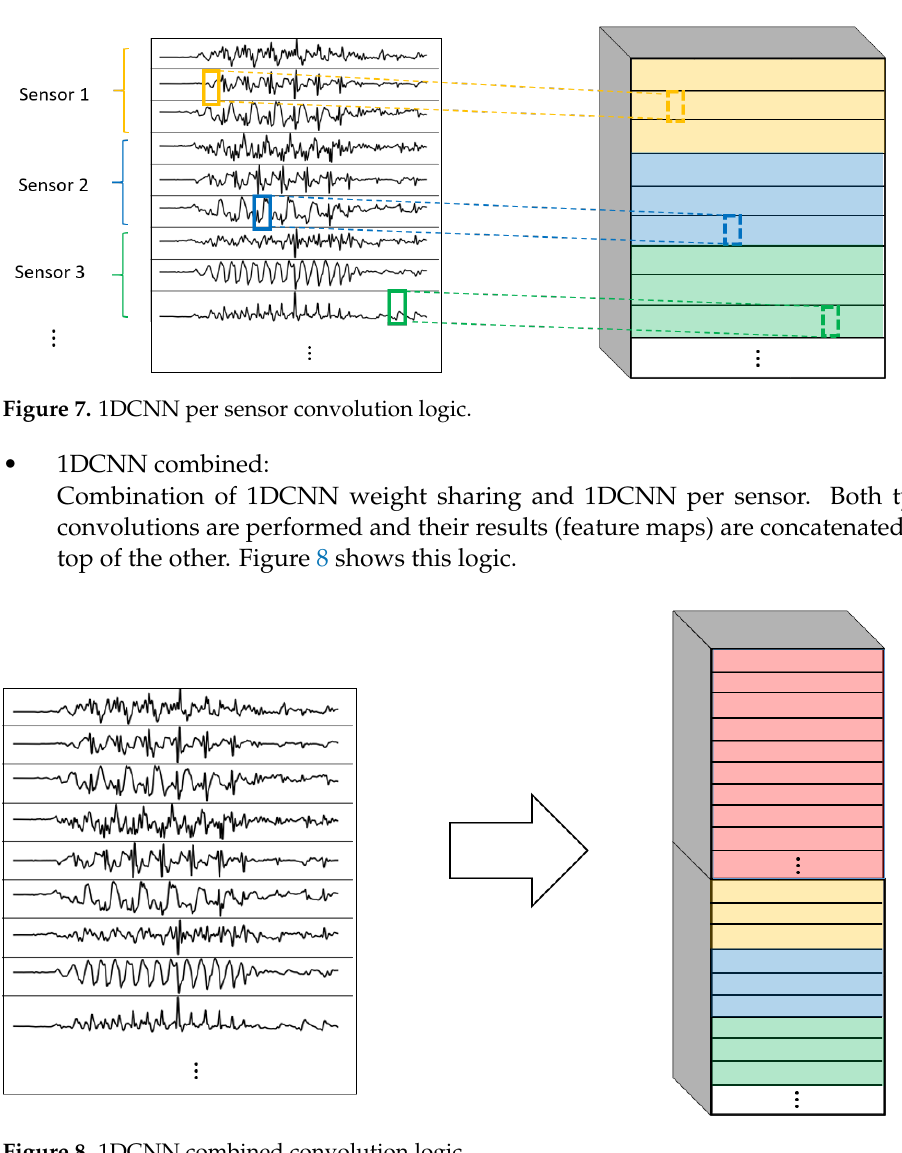
Figure 8. 1DCNN combined convolution